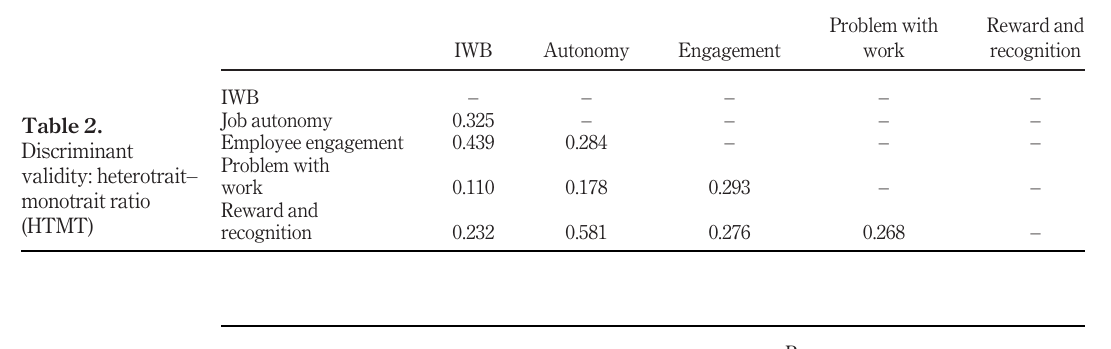
Table 3. Explained variance ( R 2 ) and predictive relevance